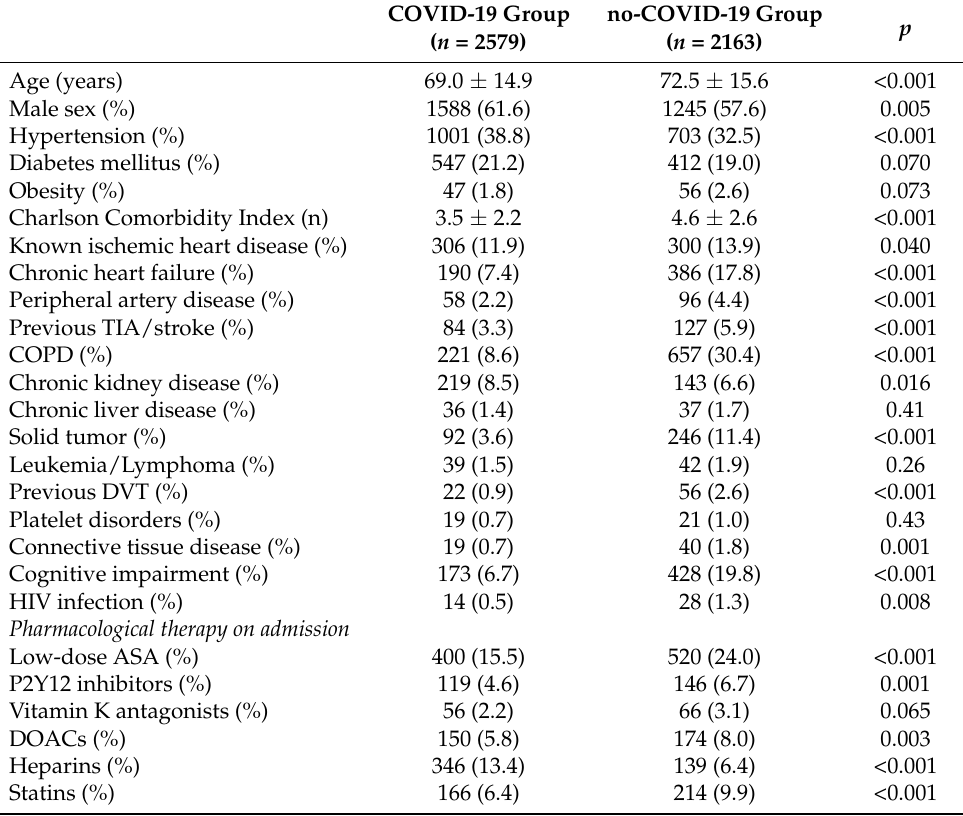
Table 1. Main clinical characteristics of the two groups of patients.